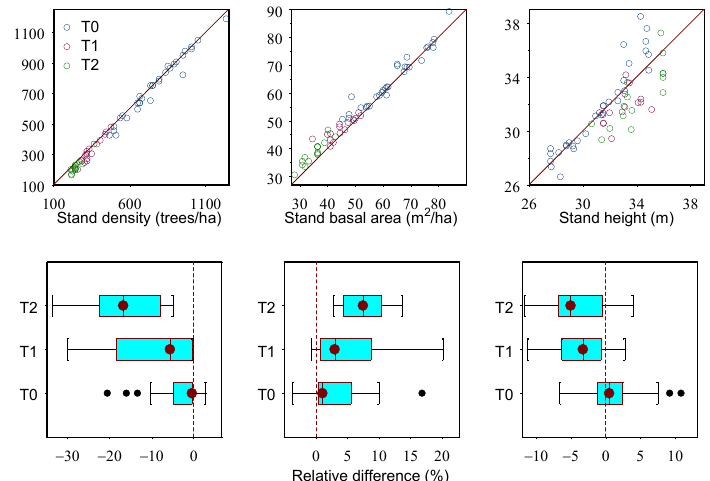
Figure 3. Scatterplots of stand attributes for the sample plots in T0 (blue), T1 (brown), and T2 (green) stands against that of their matching virtual plots with a diagonal line of unity ( top ). Boxplots of relative differences in stand attributes between the sample and the virtual plots for the three stand types ( bottom ). Relative differences are expressed as the percentages of the sample plot values.